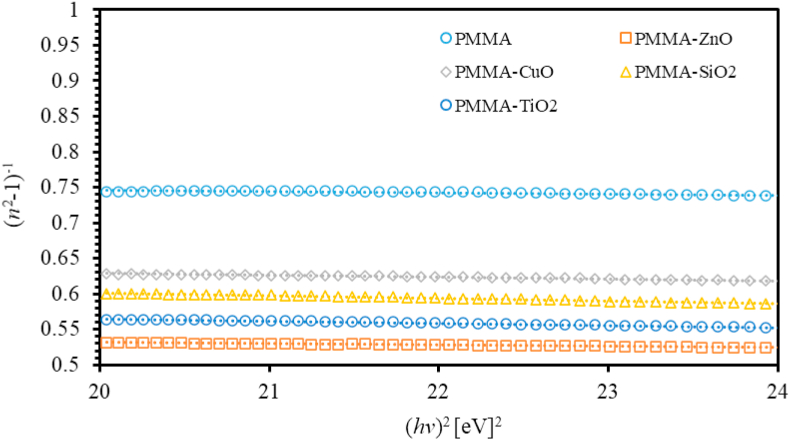
The (n2−1)−1 versus hv2 of PMMA and PMMA incorporated with ZnO, CuO, SiO2 and TiO2 NPs nanocomposites thin films.